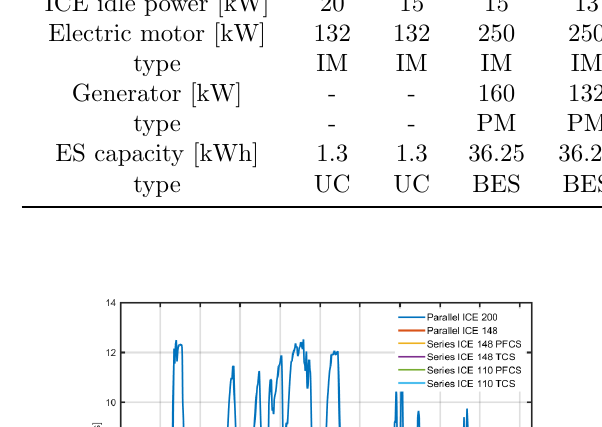
Figure 12: Working points of ICE with TCS (red dots) and PFCS (black dots) on diesel-generator efficiency map